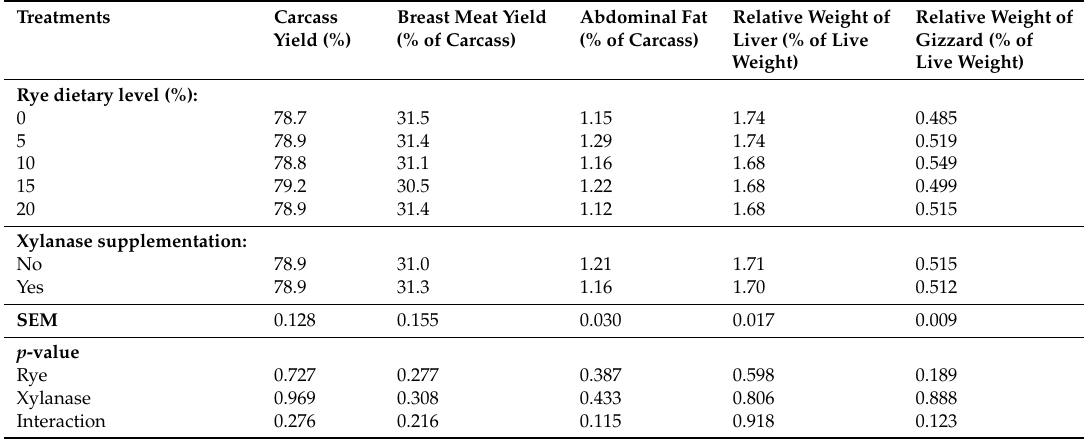
Table 6. Effects of dietary treatments on results of slaughter analysis.